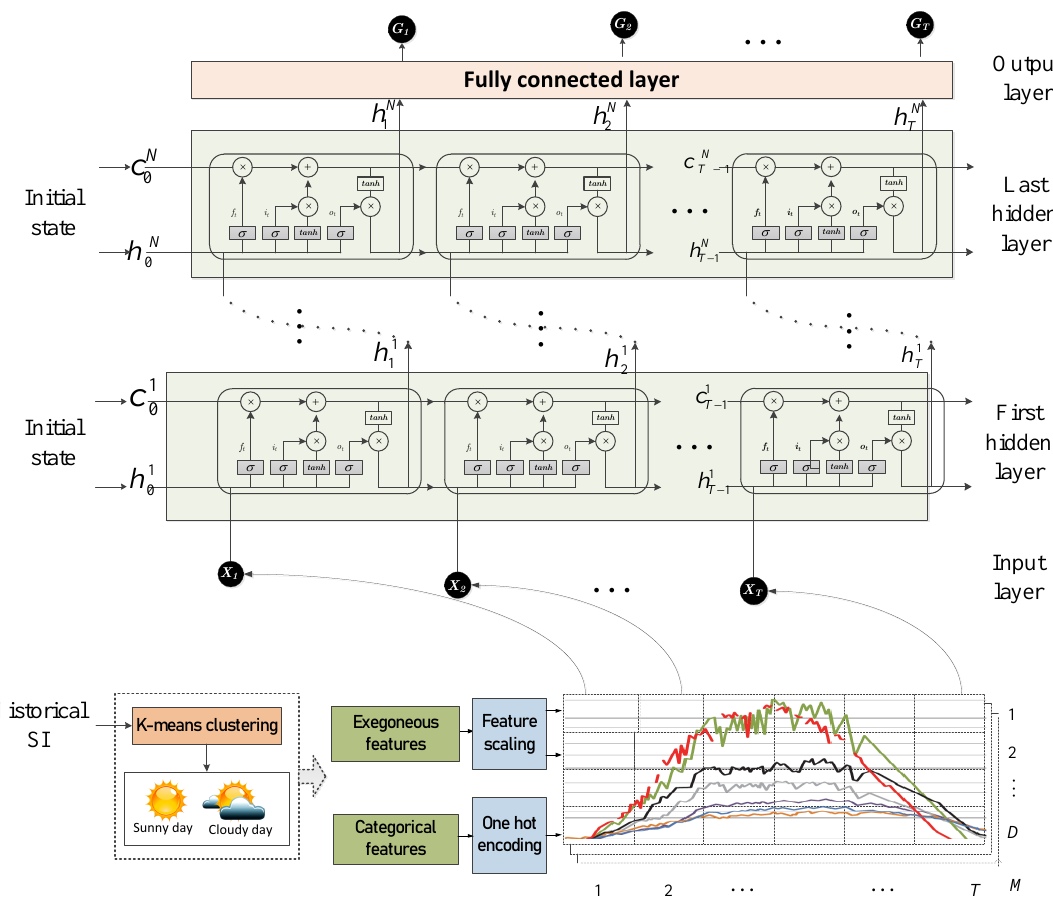
Figure 4. The LSTM-RNN architecture with k-means clustering. After classification, the LSTM network is trained for each day type. From Figure 4, dashed boxes represent the training examples that input to the LSTM network. The feature